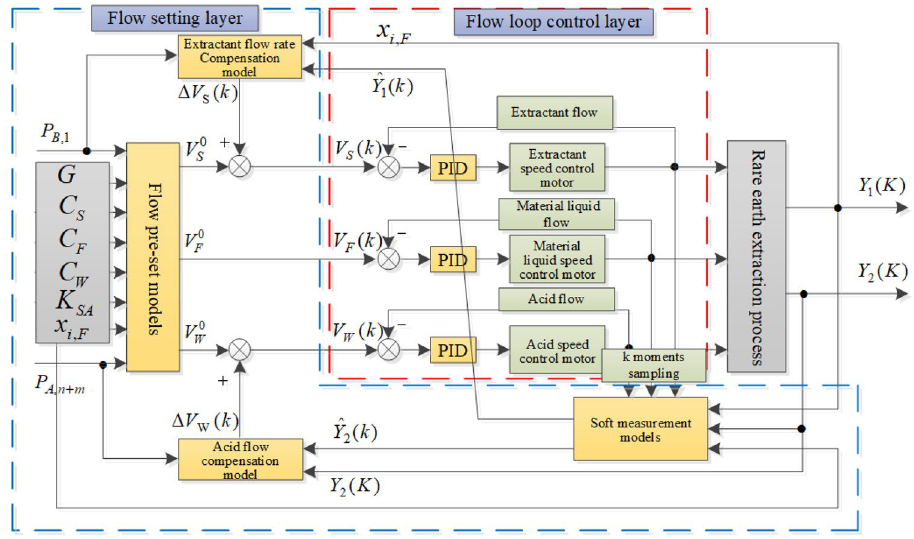
Figure 5. Control strategy for extraction process